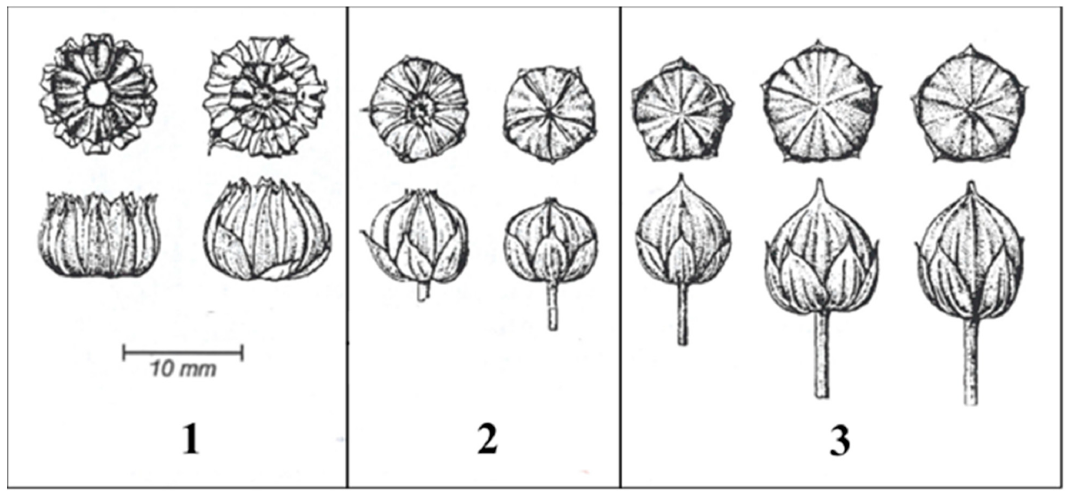
Figure 3. Degrees of spontaneous opening in mature flax capsules. Rating scale: ( 1 ) strongly dehiscent, seed shatters freely; ( 2 ) slightly dehiscent, minimal seed shattering; and ( 3 ) indehiscent, no shattering (adapted from Diederichsen and Richards, (2003)) [38].